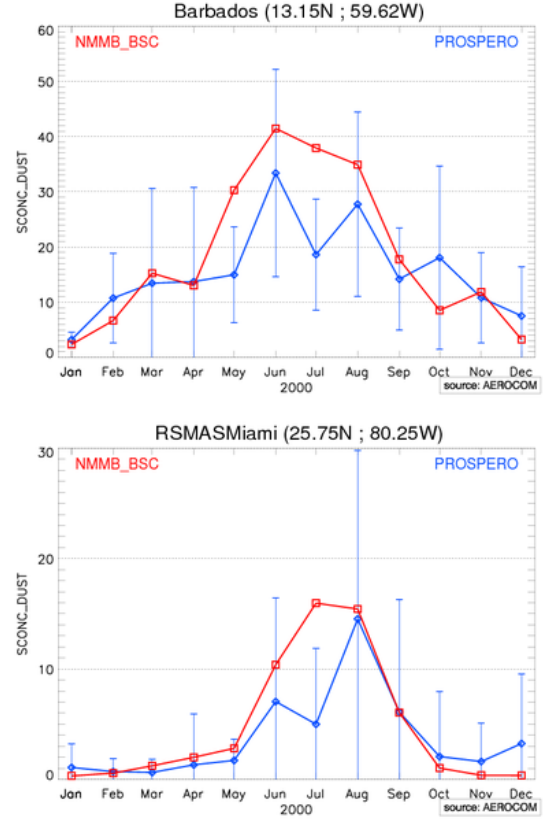
Fig. 10. Measured (blue lines) and simulated (red lines) surface concentration in Barbados (upper panel) and Miami (bottom panel) for year 2000. Standard deviation bars in blue indicate the interannual variability of the records in those locations. Units are µgm − 3